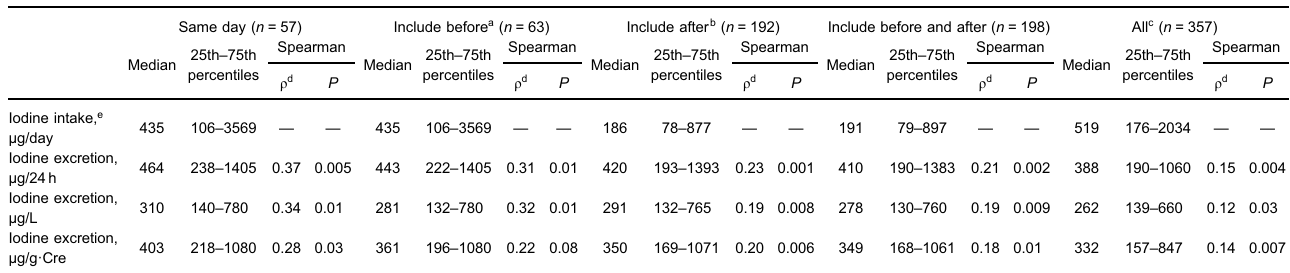
Table 4. Correlation between iodine intake calculated from the diet records and iodine excretion in Japanese adults Same day ( n =57)